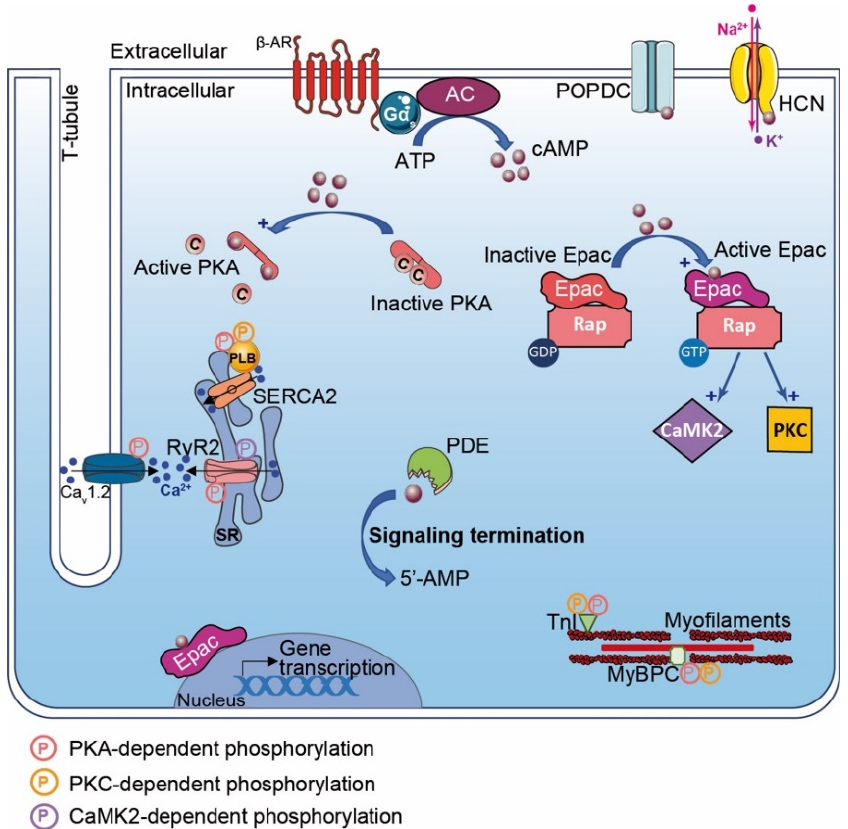
Figure 1. β -Adrenergic Receptor and cAMP signaling pathways in the heart. β -Adrenergic Receptor ( β -AR) activates adenylyl cyclase and generates pools of cAMP. cAMP (dark red-filled circles) has effects on a range of down effectors encompassing: PKA, Epac, POPDC, hyperpolarization activated cyclic nucleotide (HCN) channel and phosphodiesterases (PDEs). PKA activation leads to phosphorylation (P in pink circles) of specific substrates regulating Ca 2+ flux and cardiac excitation–contraction coupling (CEC) (e.g., PLB, Ca V 1.2 (LTCC), RyR2, TnI, MyBPC). Cyclic AMP binding to Epac favors exchange of RAP-GDP into RAP-GTP, which activates phosphorylation by PKC and CaMK2 (P in yellow and purple circles, respectively). Activated Epac regulates gene transcription. Cyclic AMP binding to HCN channels triggers ion flux (Na + , K + ) and hyperpolarization. Local concentration of cAMP gradient is limited by phosphodiesterases (PDEs), which hydrolyze cyclic nucleotide in inactive 5 (cid:48) -AMP, leading to termination of